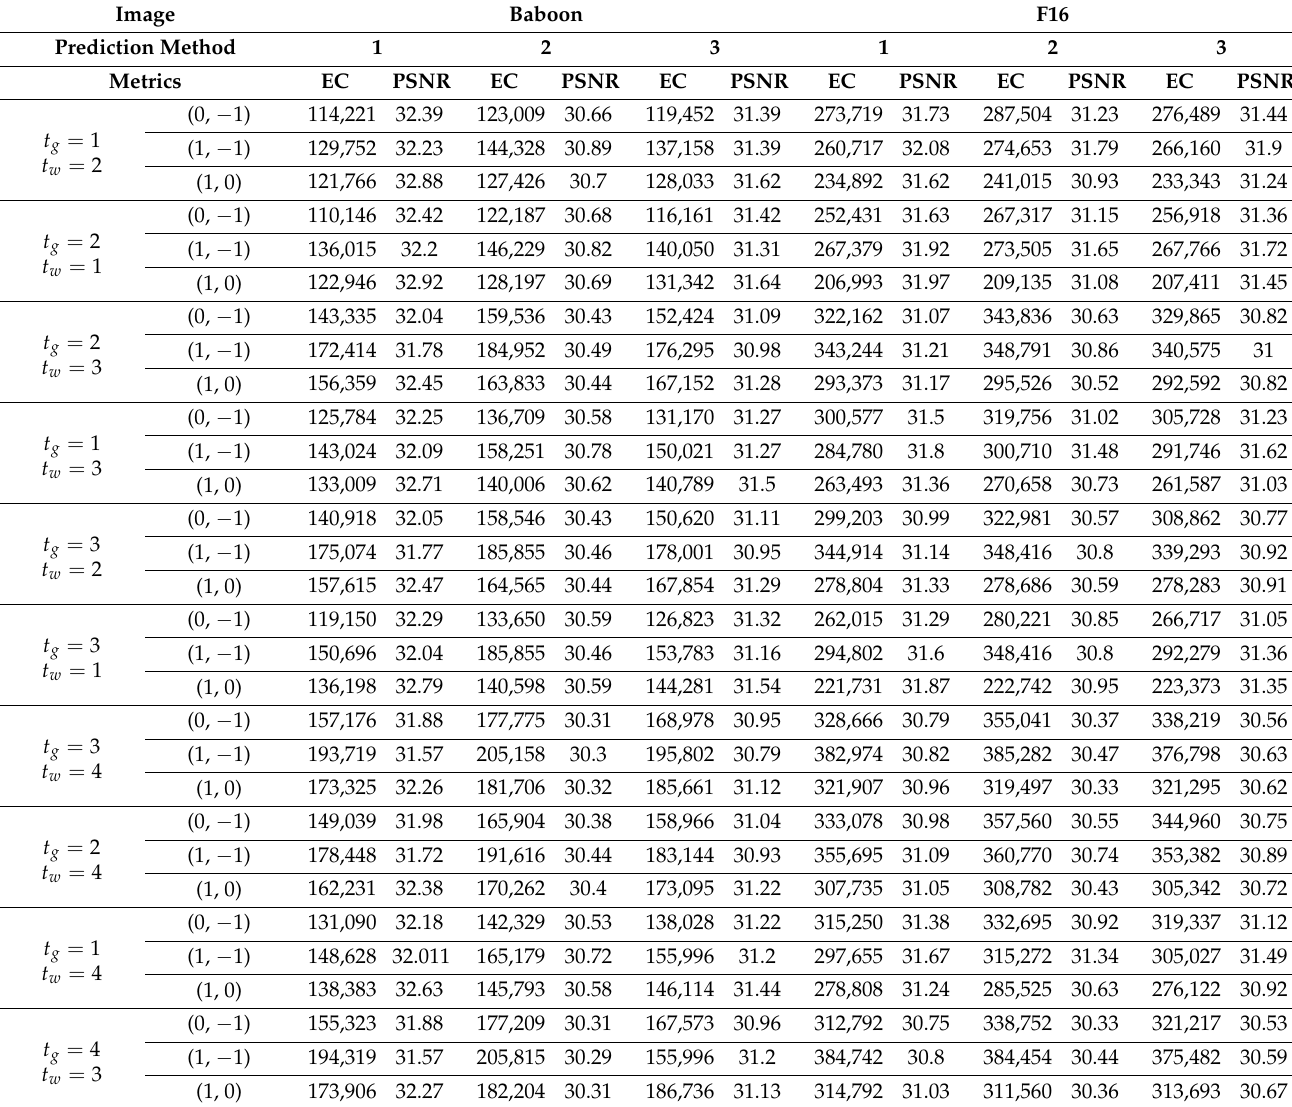
Table 8. Comparison of the performance of our proposed triple-RDH method on images “Baboon” and “F16” at different t g and t w . Image Baboon F16 Prediction